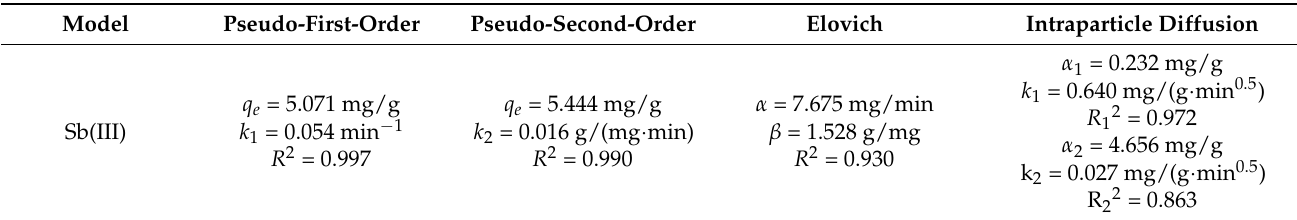
Table 6. The parameters for the adsorption kinetics of the Sb(III) sorption by FMPAs.